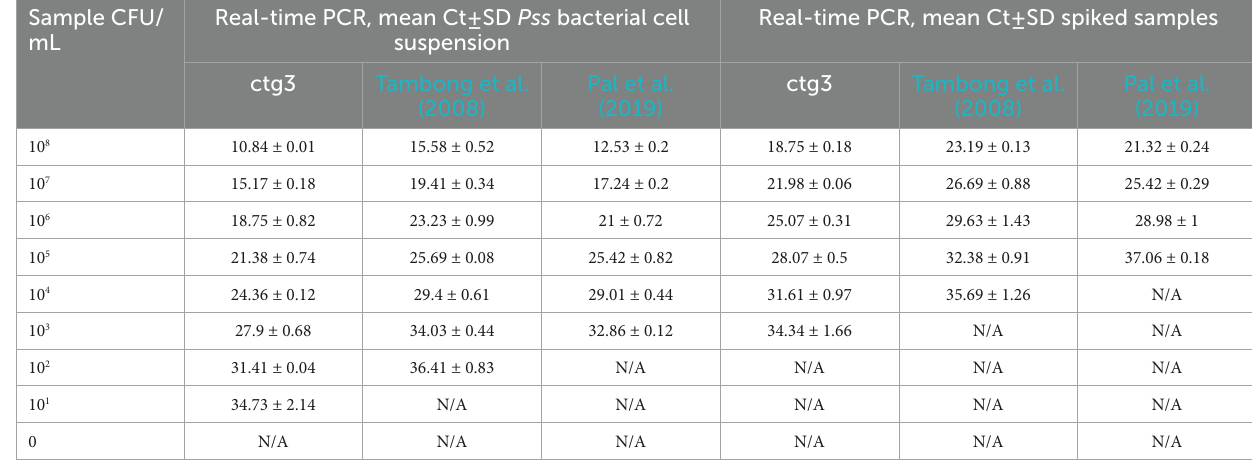
TABLE 4 Analytical sensitivity of ctg3 compared with Tambong et al., 2008 and Pal et al. (2019) performed on Pss bacterial cell suspension and spiked samples. Sample CFU/